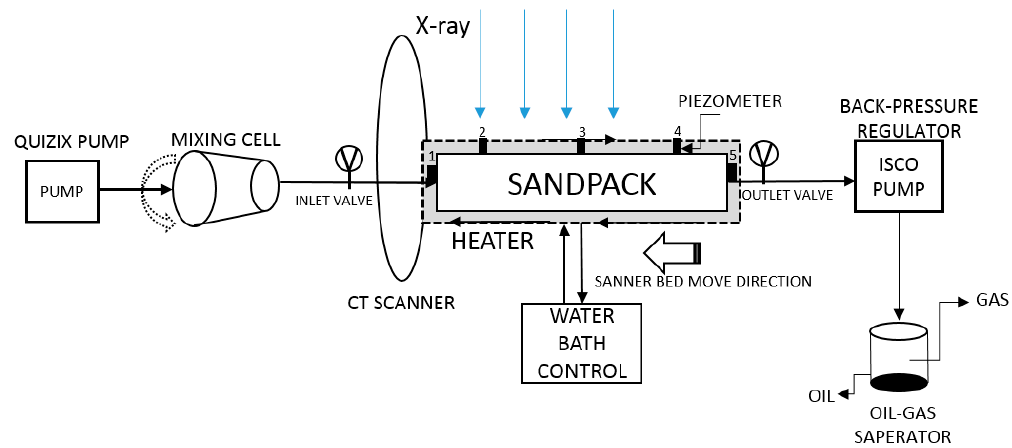
Figure 1. Experimental setup of foamy oil depletion with a computed tomography (CT) scanning system.